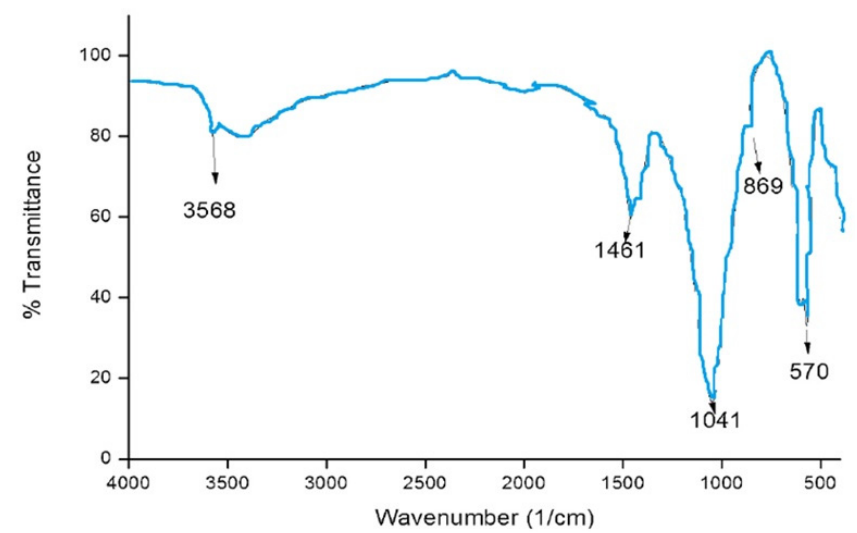
Figure 9. FTIR analysis of HAPNPs powder.